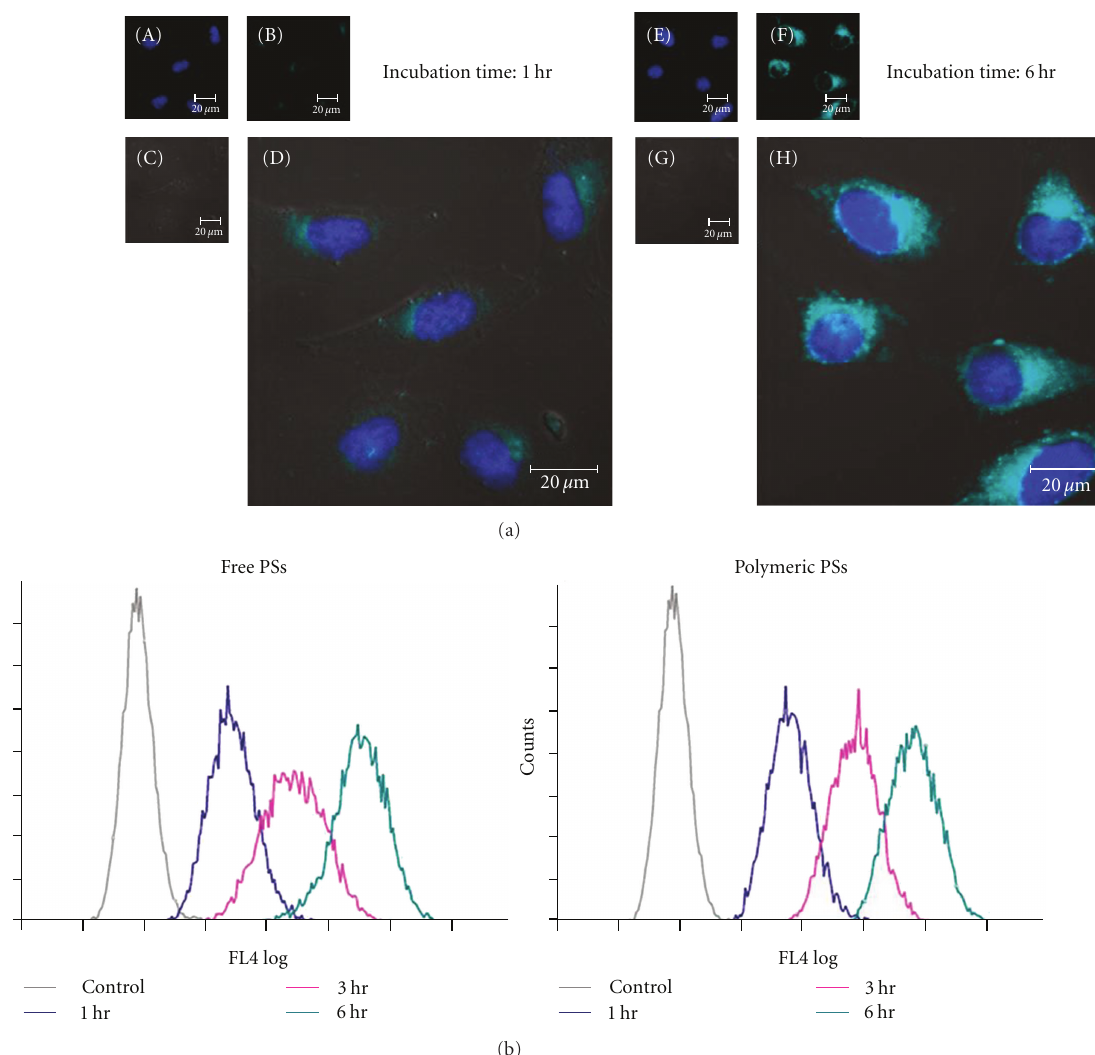
Figure 6: (a) Confocal laser scanning microscopic image of cellular internalization of CSA-based polymeric PSs in HeLa cells with incubation times of 1 and 6h, (b) fluorescence-activated cell sorting (FACS) data of HeLa cells treated with (left) free Ce6 or (right) Ac-CS/Ce6 3 for 1 (blue), 3 (purple), and 6 h (green)